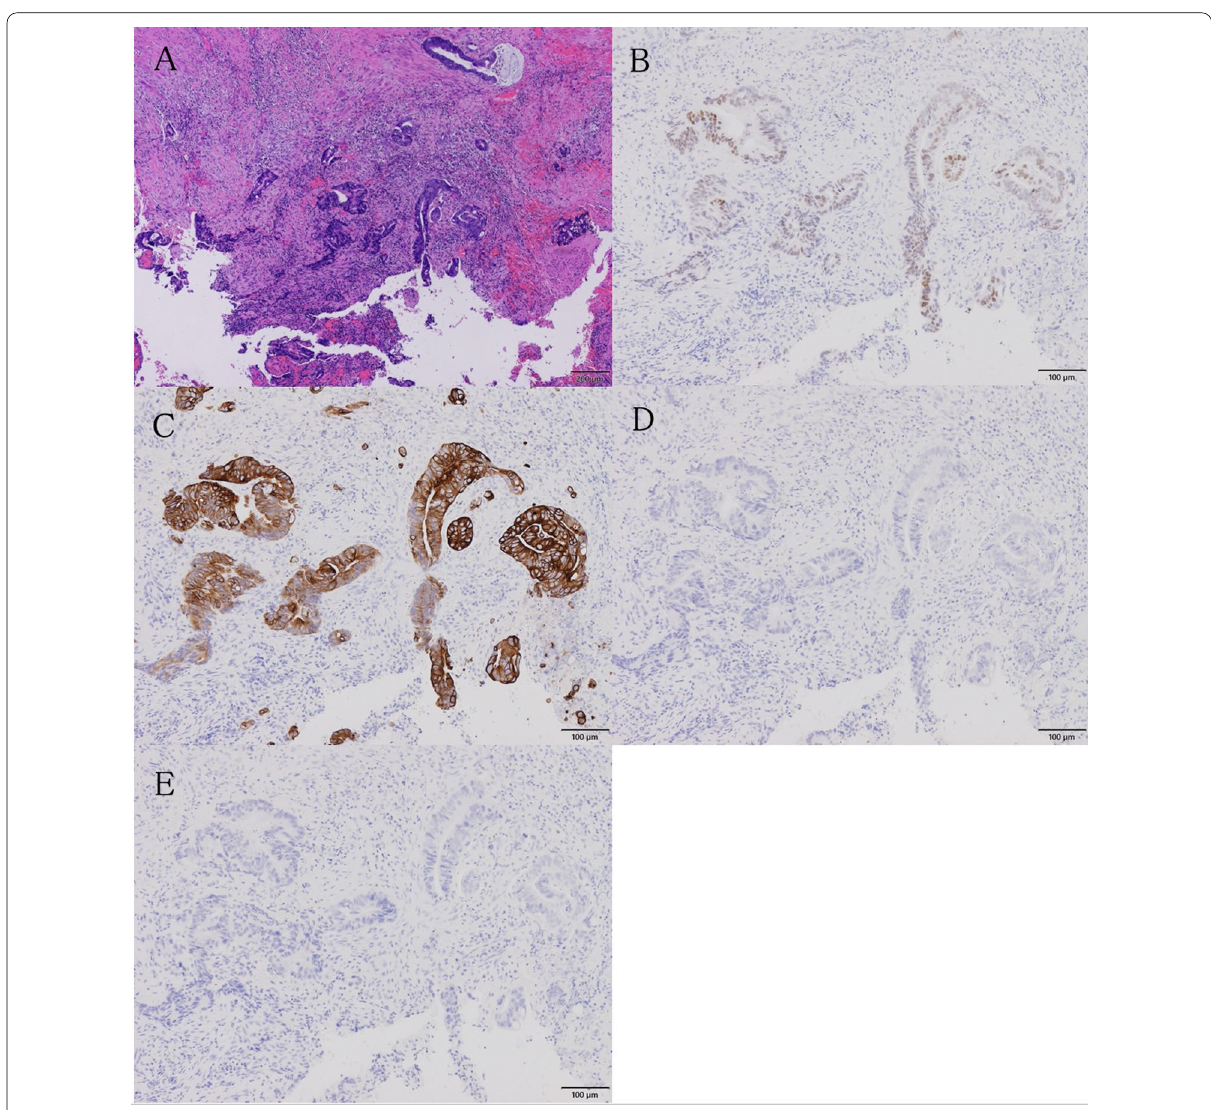
Fig. 3 Pathological findings of the anal fistula. Pathological findings show an adenocarcinoma morphologically similar to rectal cancer and tumor cells infiltrating the proximal margin ( A ). On immunohistochemistry, the sample is CDX-2 positive ( B ), CK20-positive ( C ), CK7-negative ( D ),